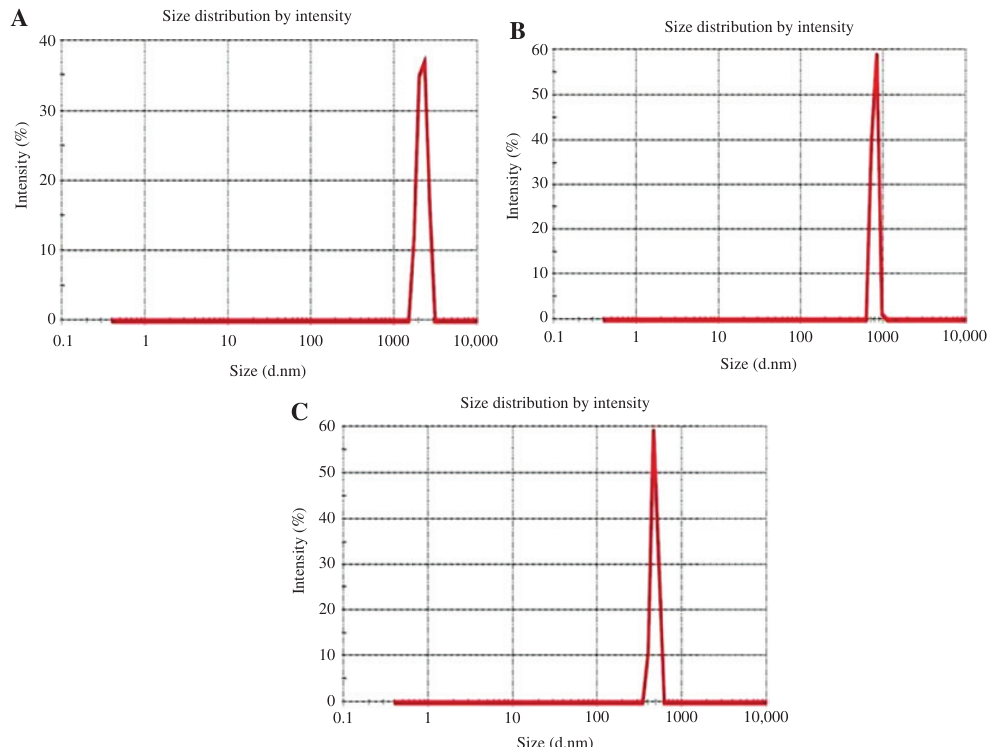
composites fabricated at 20 min AT and HTs of (A) 20 min, (B) 30 min, and (C) 40 min. 2